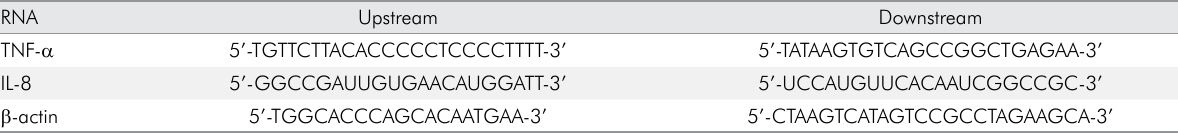
Table 3. Sequences of primers used in the study.